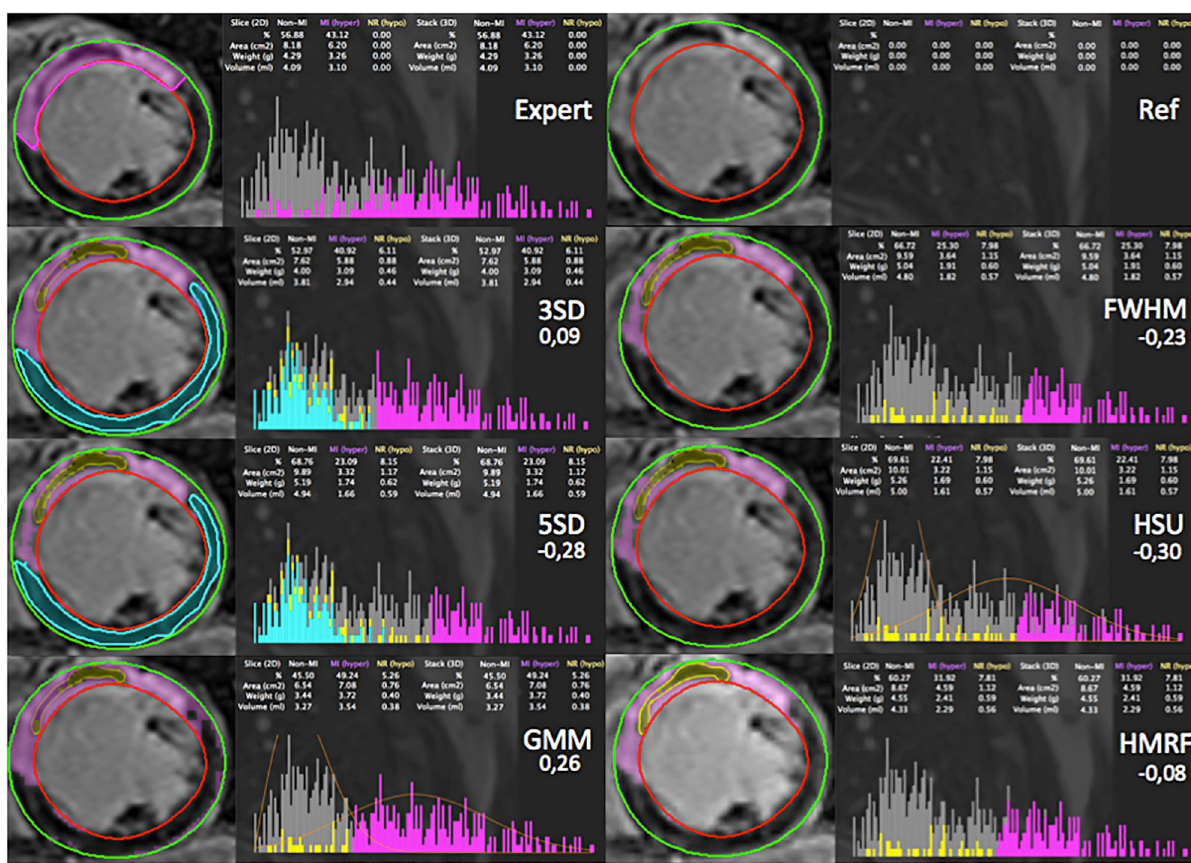
Fig 8. Comparison between the manual segmentation made by an expert (including a manual definition of the MVO region), and the segmentation made by each of the methods within CMRSegTools. For each segmentation, the figure shows: epicardium (green) and endocardium (red) contours from the myocardial segmentation, lesion segmentation (magenta), remote healthy myocardium (turquoise), no-reflow region (yellow), histogram, quantification statistics and relative error.